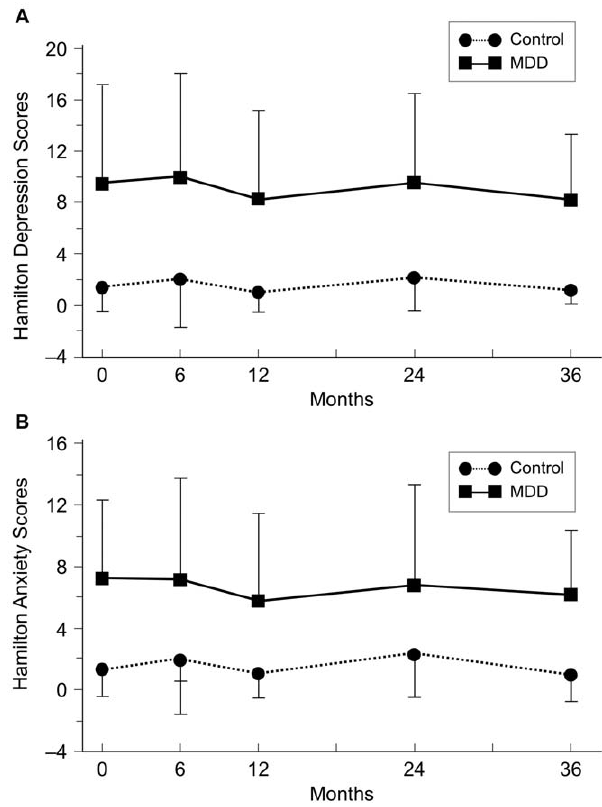
Figure 2. Hamilton depression (upper panel) and anxiety (lower panel) scores in women with MDD and control women over time. Both depression and anxiety scores were relatively low and remained stable over time in women with MDD. As expected, scores for depression and anxiety were much higher in women with MDD vs. control